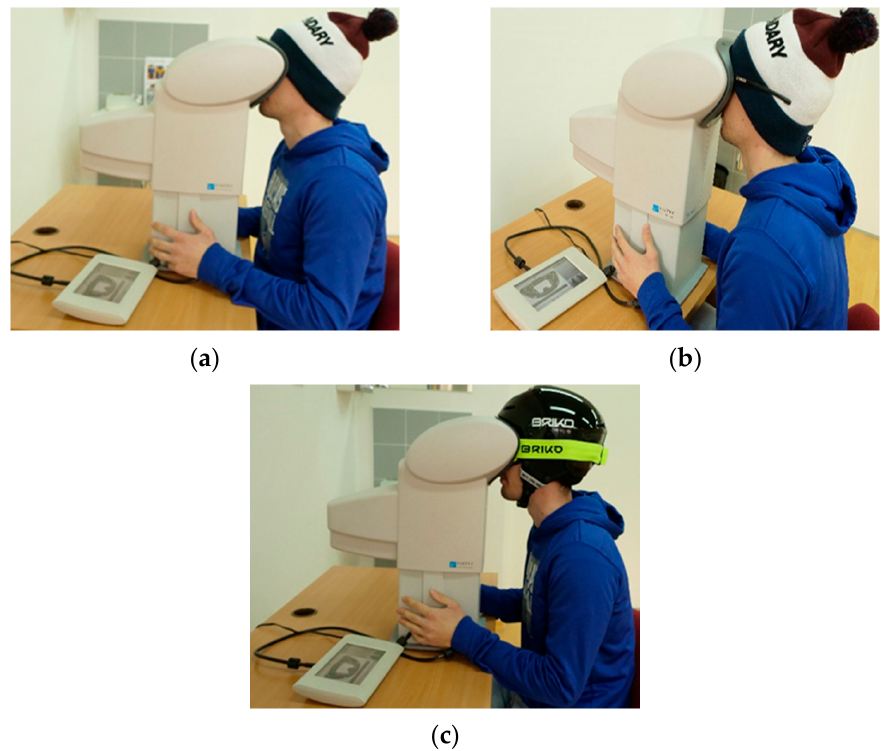
Figure 2. ( a ) Testing protocol using only ski cap; ( b ) testing protocol using ski cap and sunglasses; ( c ) testing protocol using ski helmet and ski goggles.